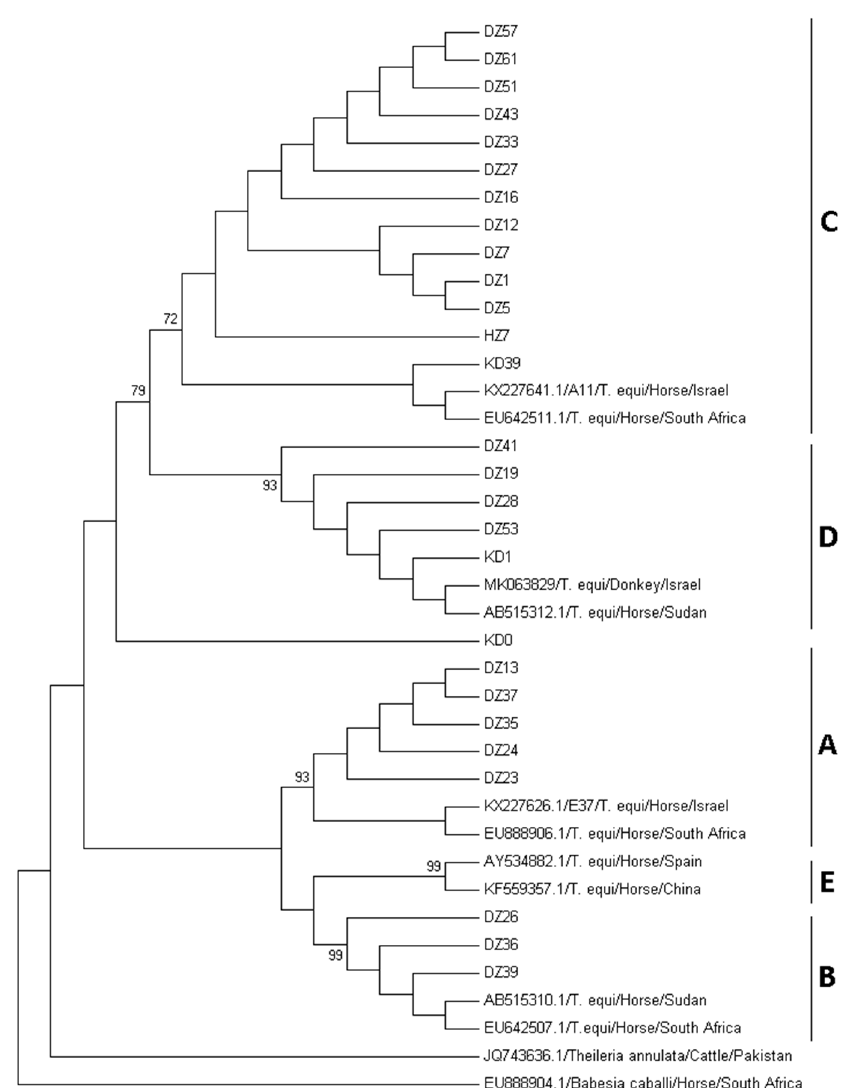
Figure 1. Phylogenetic analysis of T. equi 18S rRNA gene from donkeys and horses from Nigeria. The sequences obtained in this study were compared with previously published sequences of T. equi and other apicomplexan parasites obtained from the GenBank. The phylogenetic tree, which included 363 positions, was constructed using neighbor joining algorithm and Kimura 2-parameter + G + I model in MEGA7 software. Three samples with shorter sequences were not included in this analysis. Z—